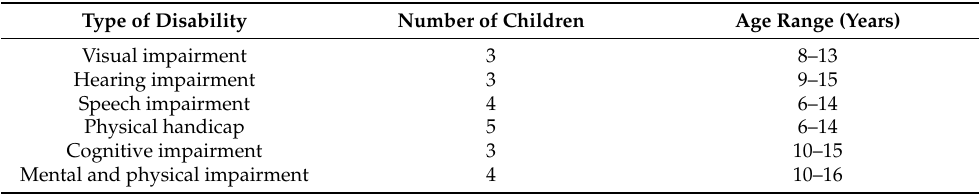
Table 1. Characteristics of the